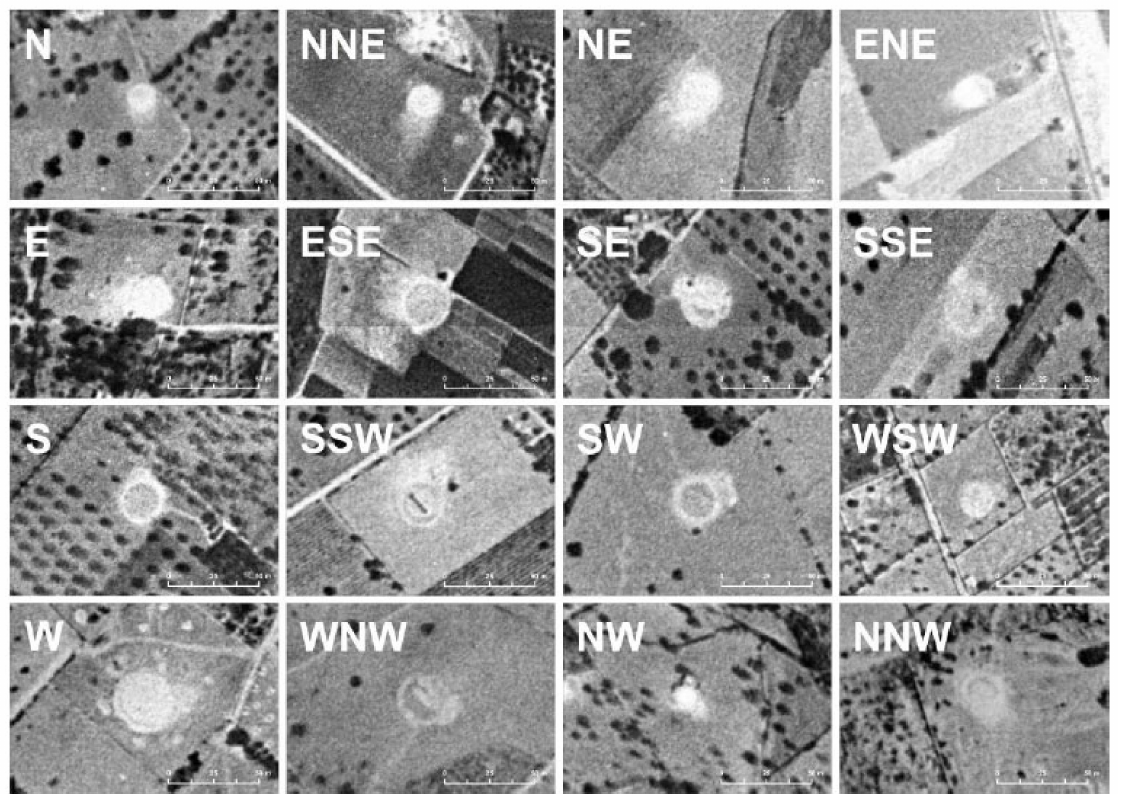
Figure 7. Morphological 2D aspect of 16 different threshing floors captured by the 1956 aerial photography, and their respective 16 anemographic marks corresponding to the predominant wind direction at the site. Work scale: